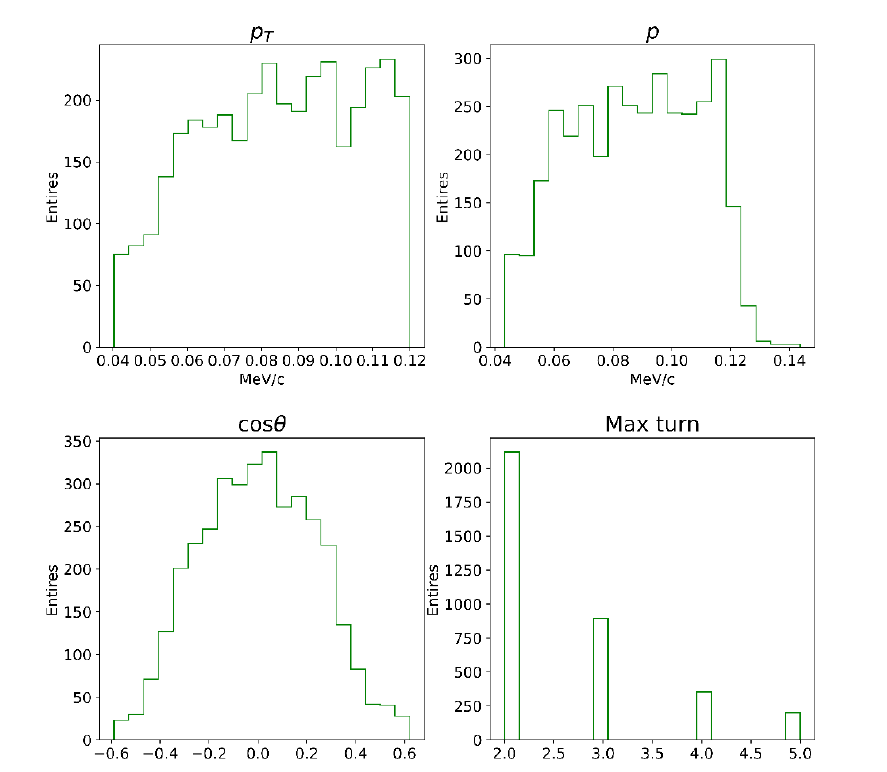
Fig. 4. Distributions of the training dataset